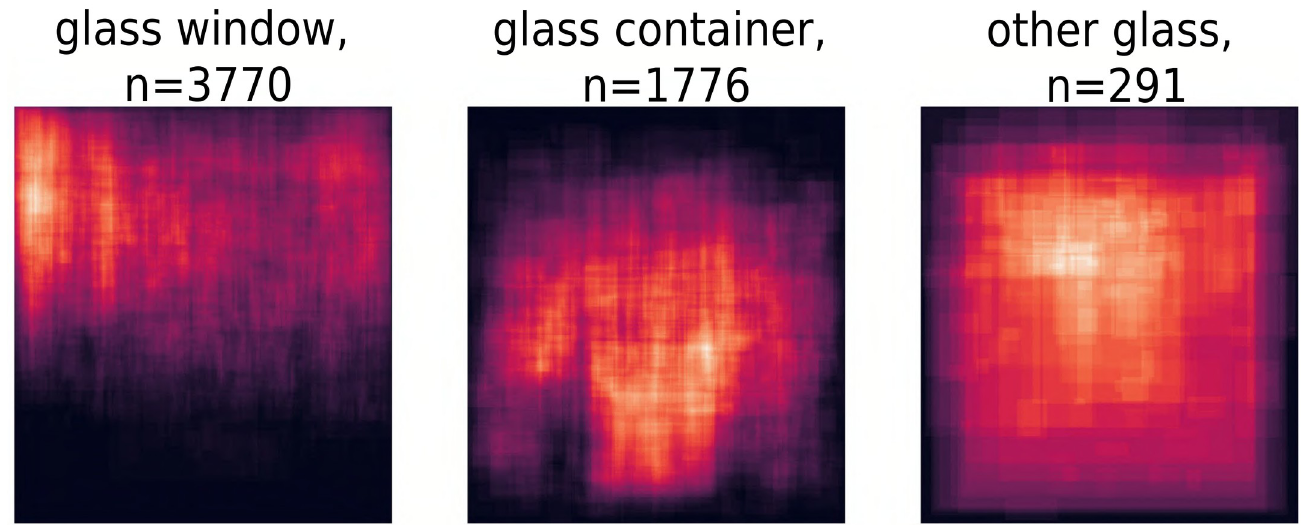
Fig 9. Material heatmaps for glass sub categories. For glass windows, it is interesting to see the clustering in the top-left corner, which is in agreement with the artistic convention of having light come from the top left.